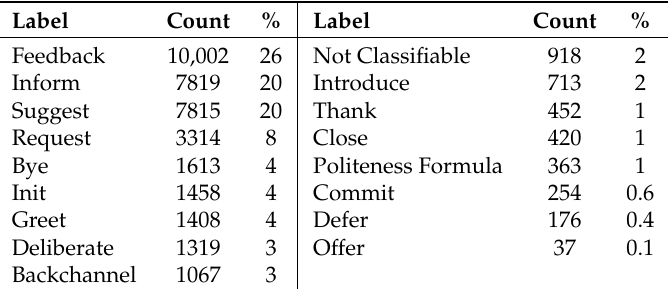
Table 5. Label distribution in the VERBMOBIL corpus.